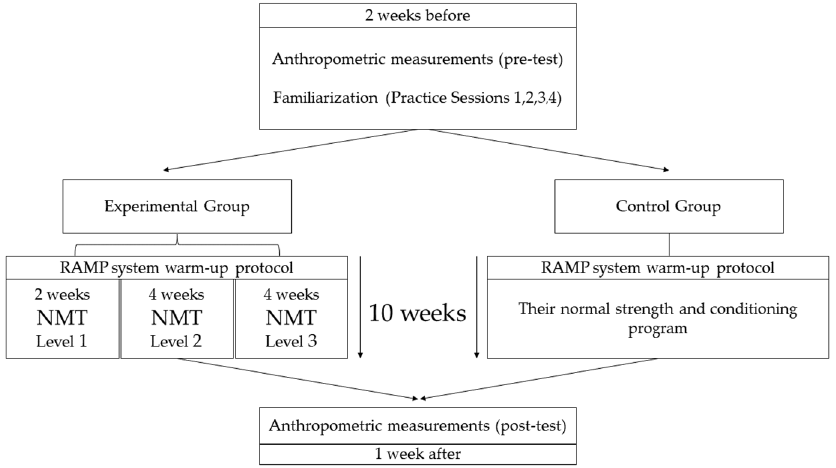
Figure 2. Project design timeline. NMT: neuromuscular training; RAMP: rise, activate, mobilize, and potentiate.